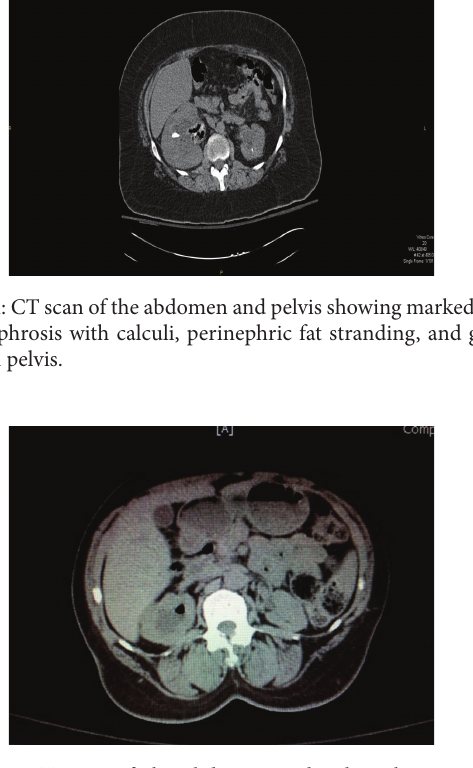
Figure 2: CT scan of the abdomen and pelvis showing right- sided ureteropelvic junction stenosis with moderate to marked hydronephrosis, air in the collecting system and intraparenchymal area, and increased echogenicity of the right renal parenchyma suggestive of parenchymal